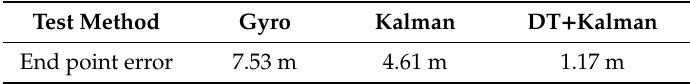
Table 4. Comparison of the end point positioning errors in indoor track 2 .